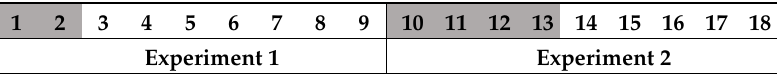
Table 1. Timeline. First row indicates the week since by-products were included in the diet: grey zone defines adaptation periods without milk sampling, white zones defines weeks when samplings were